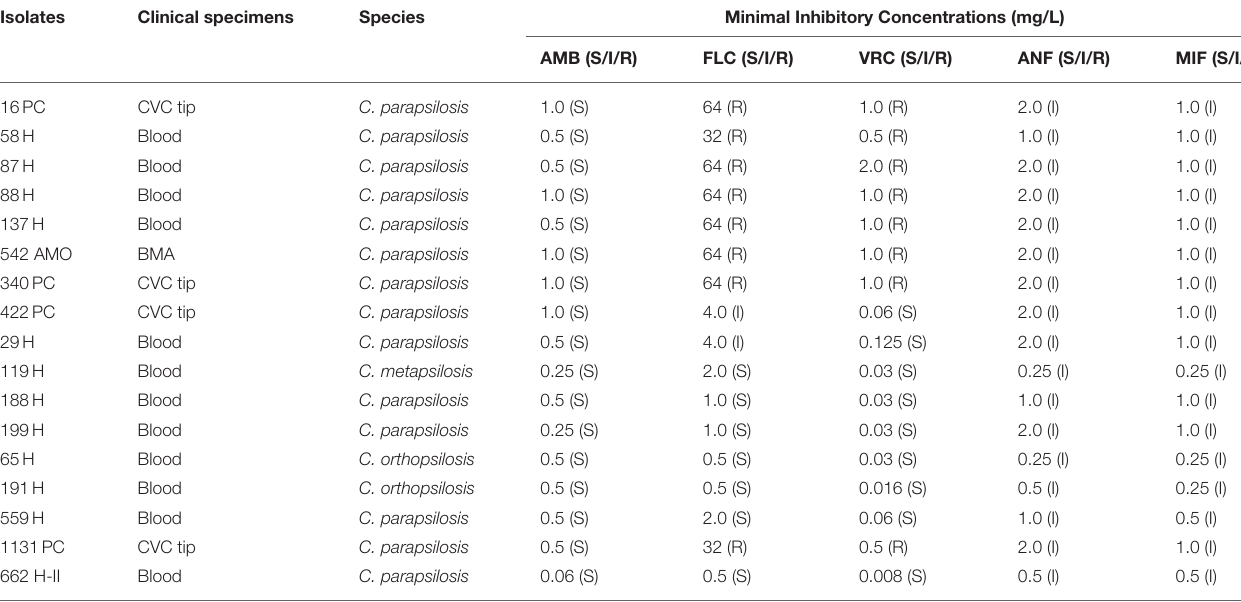
TABLE 1 | Identification and in vitro susceptibility testing of 17 Candida parapsilosis complex species from HUMAP-UFMS.